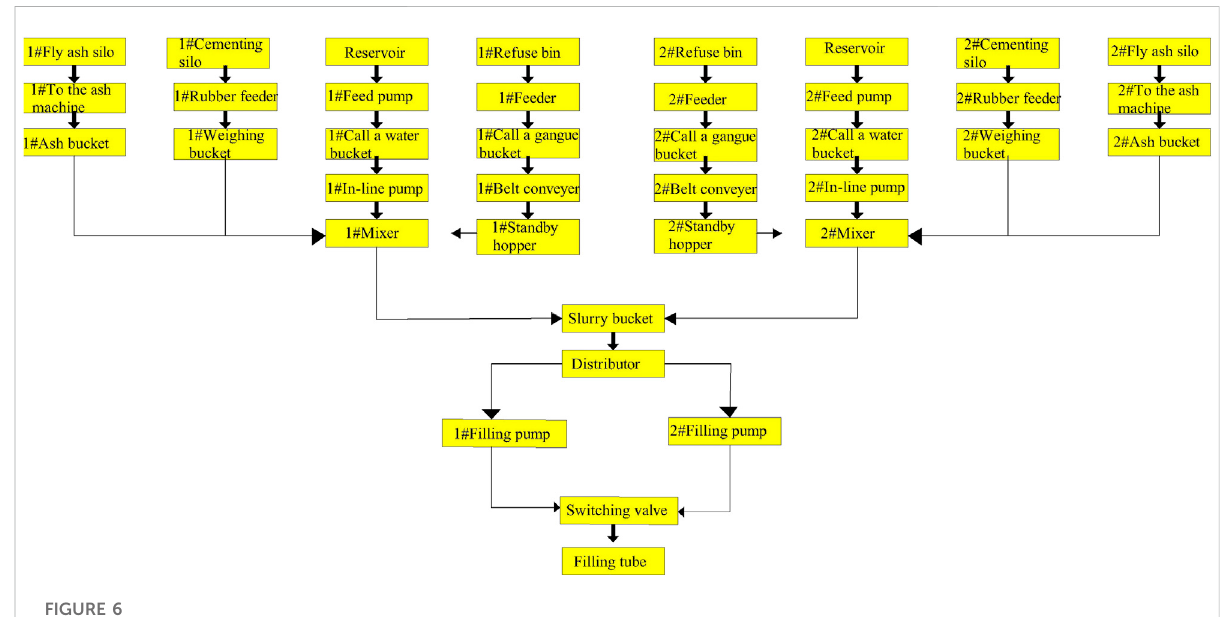
FIGURE 6 Flow diagram of the proportioning mixing pumping process.